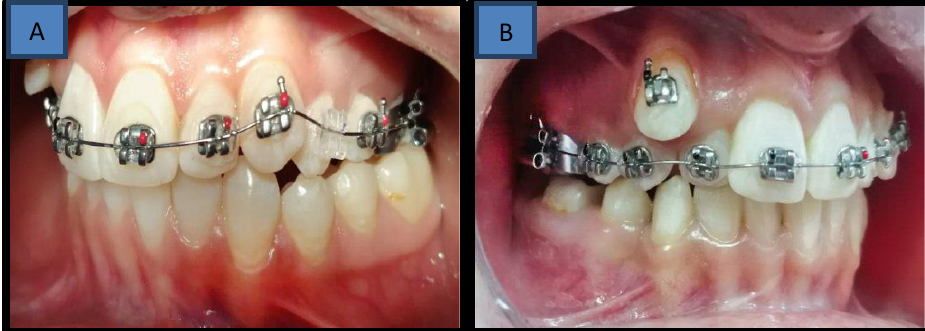
Figure 1: A; Stainless steel bracket bonded on tooth number 14, B; Sapphire bracket bonded on tooth number 24.